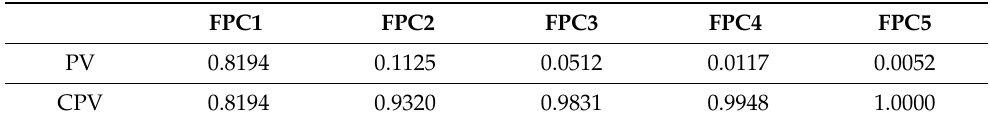
Table 2. Total Cumulative Percentage Variations in the Daily COVID-19 Mortality Data of Five Functional Principal Components for Daily COVID-19 Mortality Data. FPC1 FPC2 FPC3 FPC4 FPC5 PV 0.8194 0.1125 0.0512 0.0117 0.0052 CPV 0.8194 0.9320 0.9831 0.9948